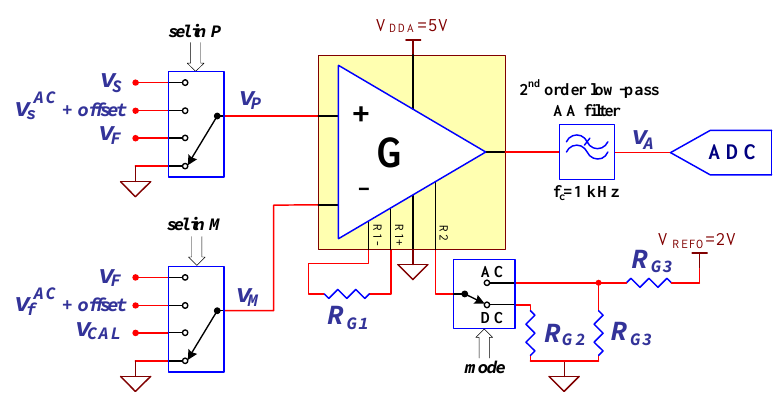
Figure 7. Signal conditioning and